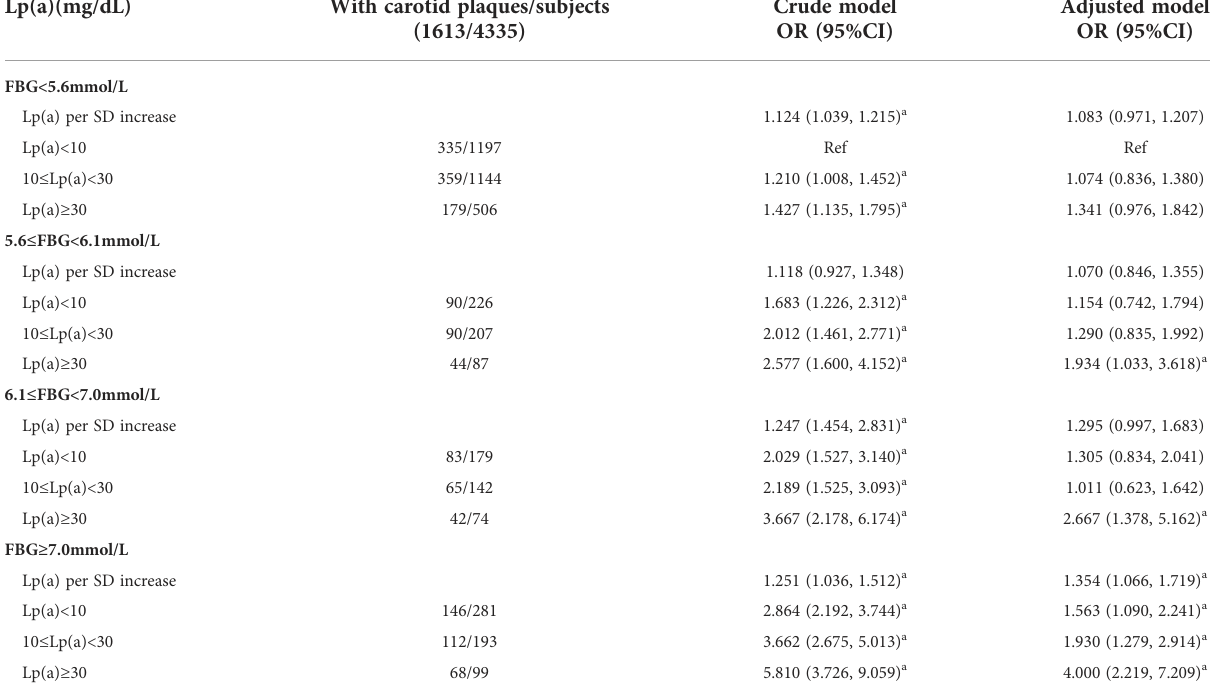
TABLE 2 Lp(a) levels in relation to carotid plaques in fatty liver patients with different glucose